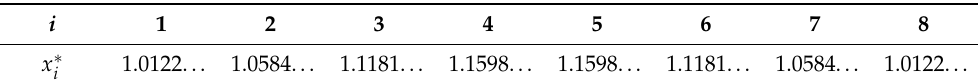
Table 2. Numerical solution of